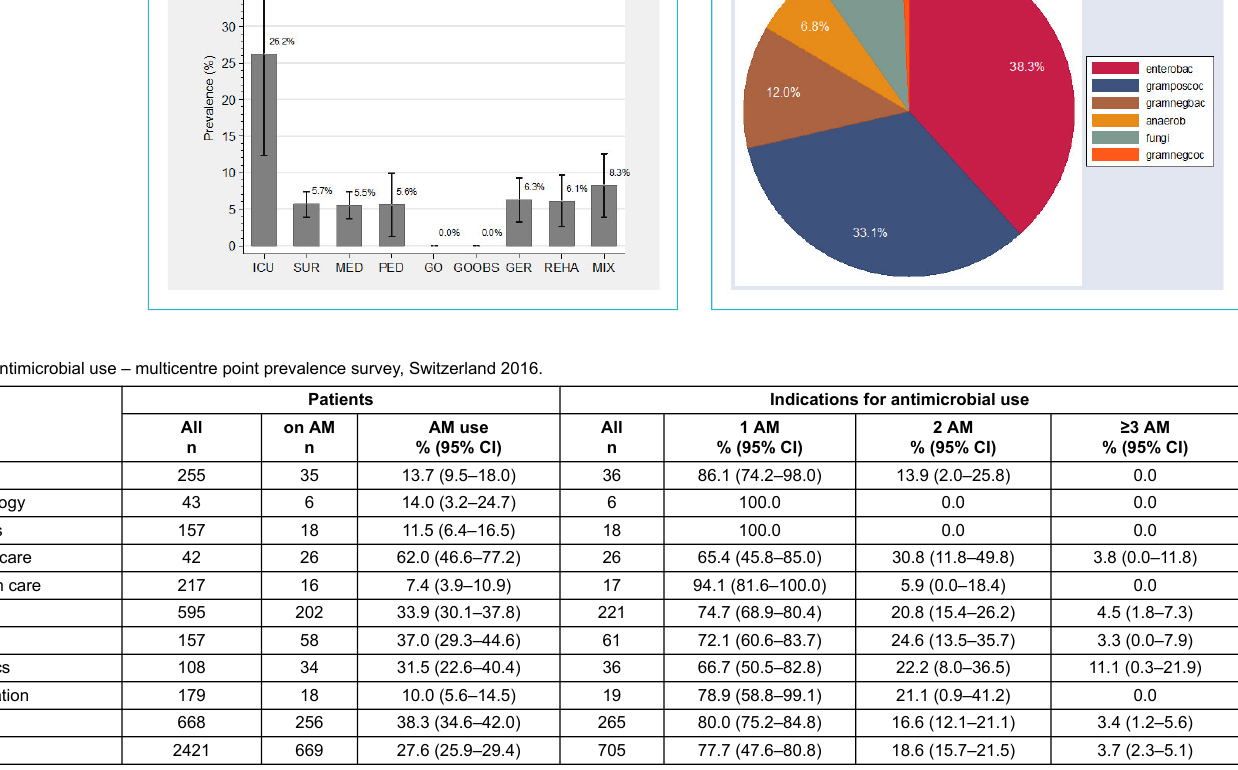
Figure 2: Prevalence of healthcare-associated infections by ward specialty – multicentre point prevalence survey, Switzerland 2016.GER = geriatrics; GO = Gynaecology; GOOBS = obstetrics; ICU = intensive care unit; MED = medicine; PED = paediatrics; REHA = rehabilitation; MIX = mixed unit; SUR = surgery